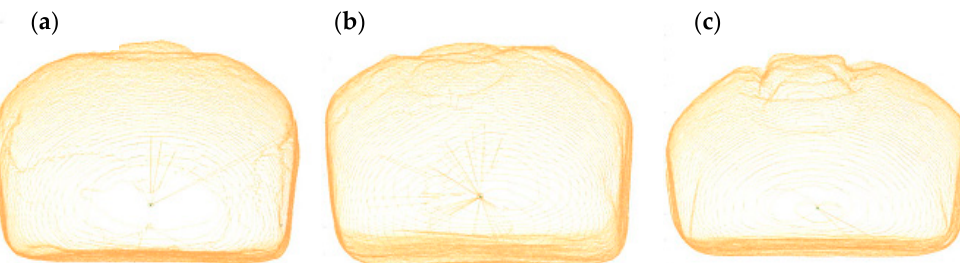
Figure 8. Bread volume and bread aspect ratio by Volscan profiler. ( a ) control wheat-rye bread; ( b ) bread with RLF 5% (bread with the addition of legume flour with the highest volume); ( c ) bread with BBF 15% (bread with the addition of legume flour with the lowest volume).